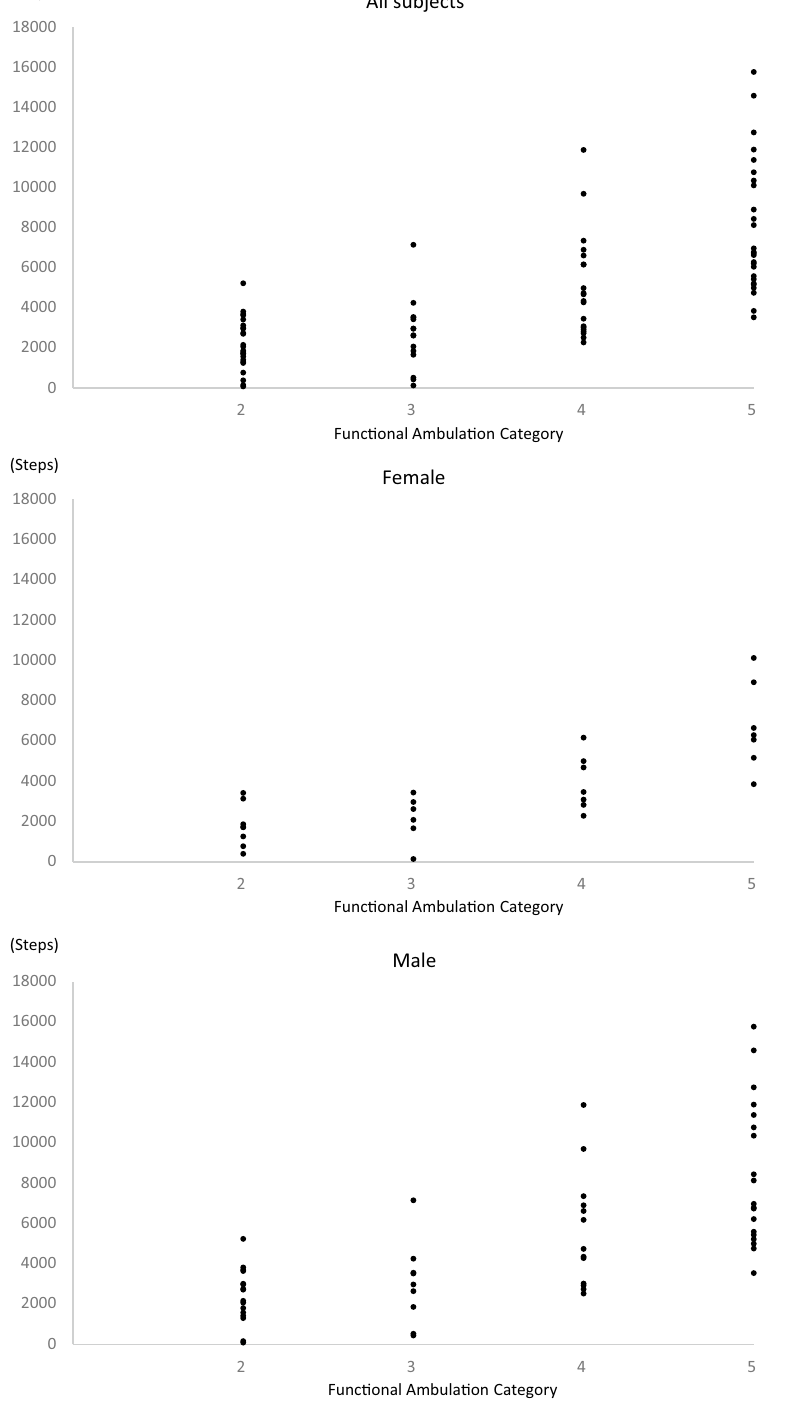
Figure 2. Scatter plot of Functional ambulation category and daily number of